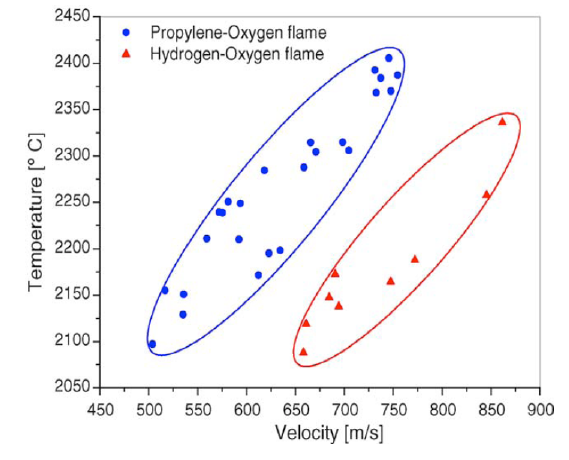
Figure 6. A first-order process map for HVOF alumina, showing particle temperature and velocity ranges for propylene-oxygen and hydrogen-oxygen fuel mixtures [15].